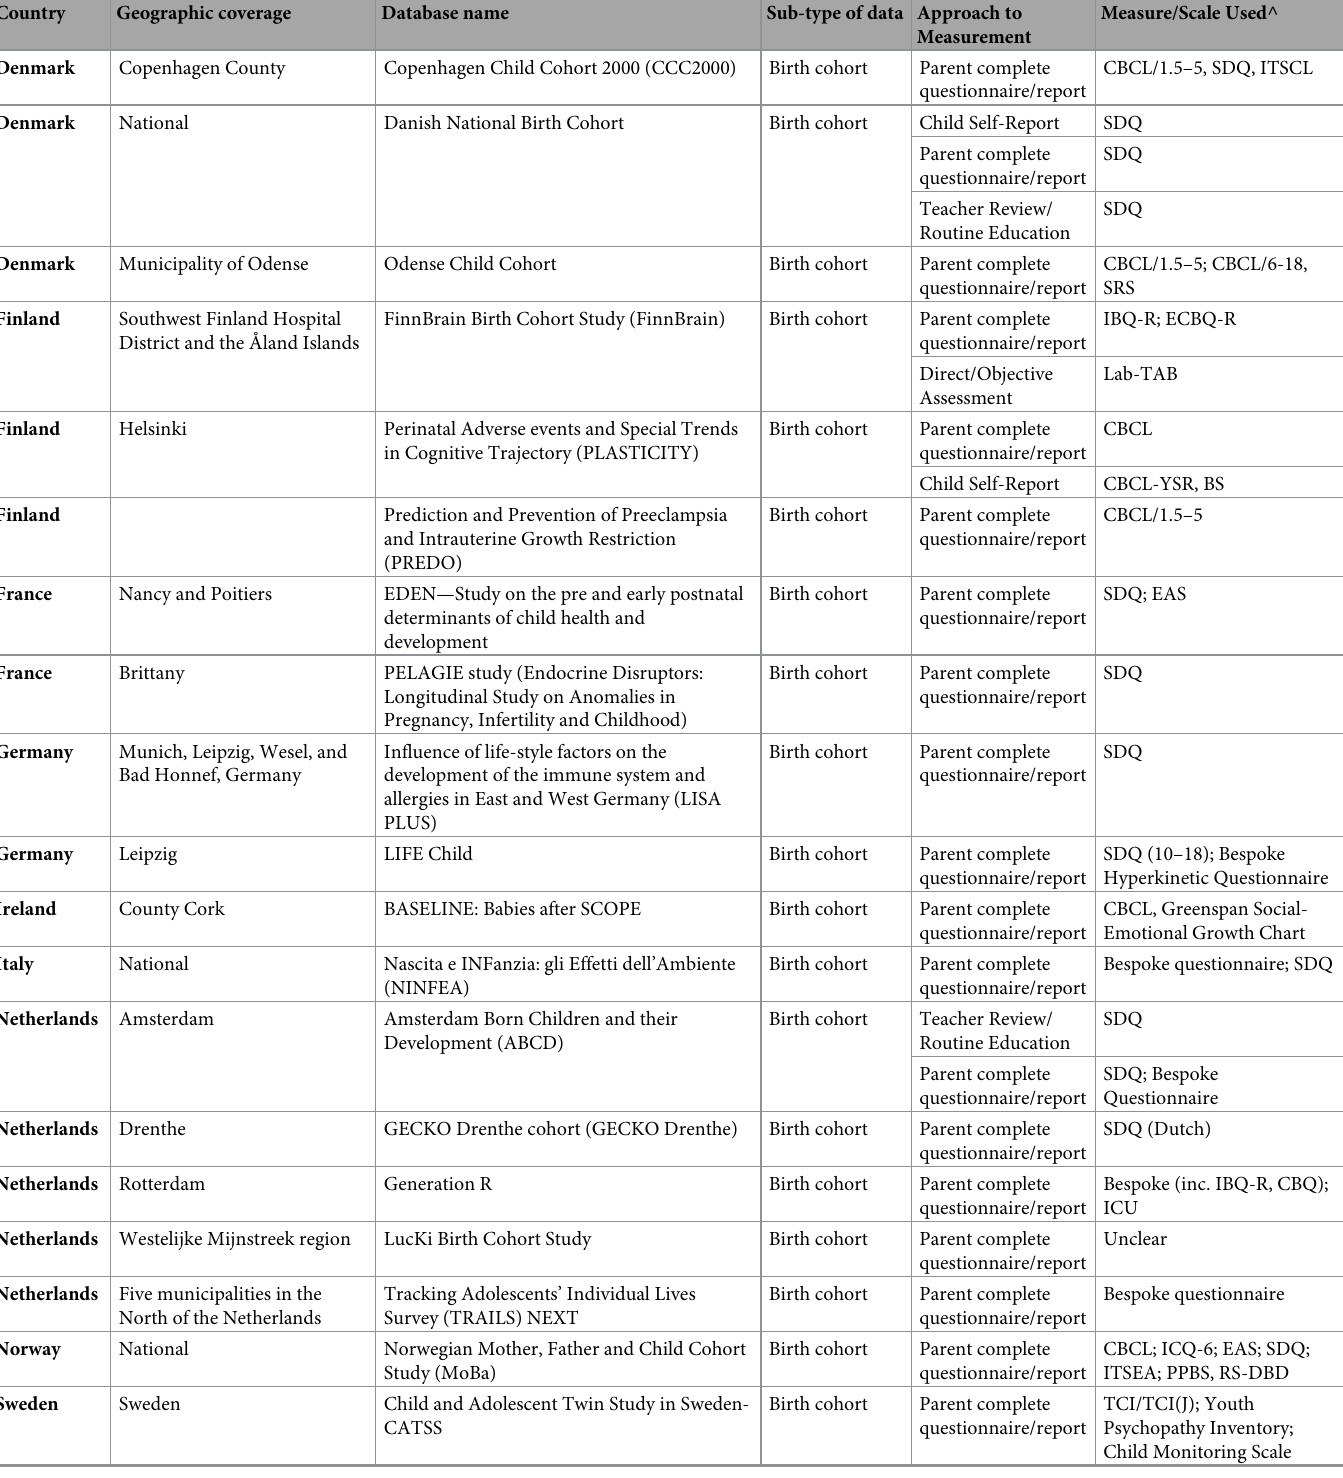
Table 2. Data sources which record child behaviour.